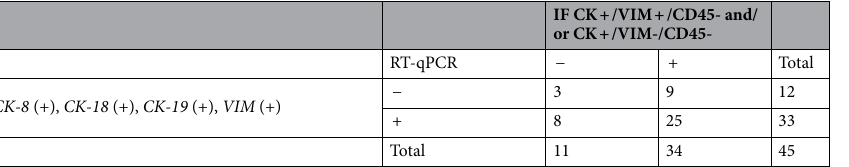
Table 2. Comparison of CTC detection using RT-qPCR (CTC size-based enrichment with Parsortix) based on the expression of CK-8, CK-18, and/or CK-19, and/or VIM and IF staining (CTC size-based enrichment with ISET) based on CK-8/CK-18/CK-19, and/or VIM detection (n = 45). Concordance: 28/45 (62.2%). McNemar test, p =